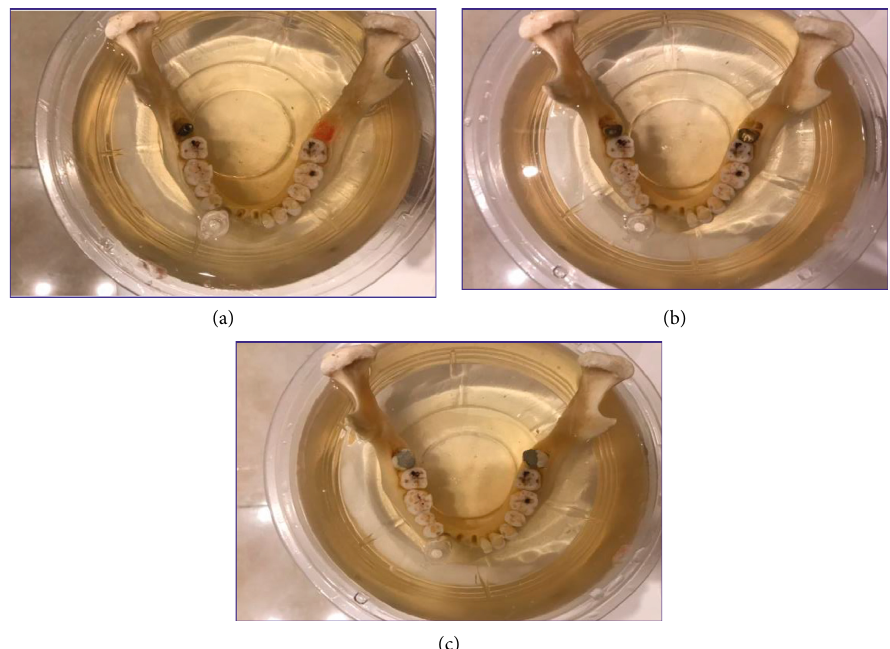
Figure 1: Placement of the titanium implant (a) cobalt-chromium intracanal post (b) amalgam restoration (c) and in a dry human mandible. The bodies of the phantoms were made of thin plastic and filled with ballistic